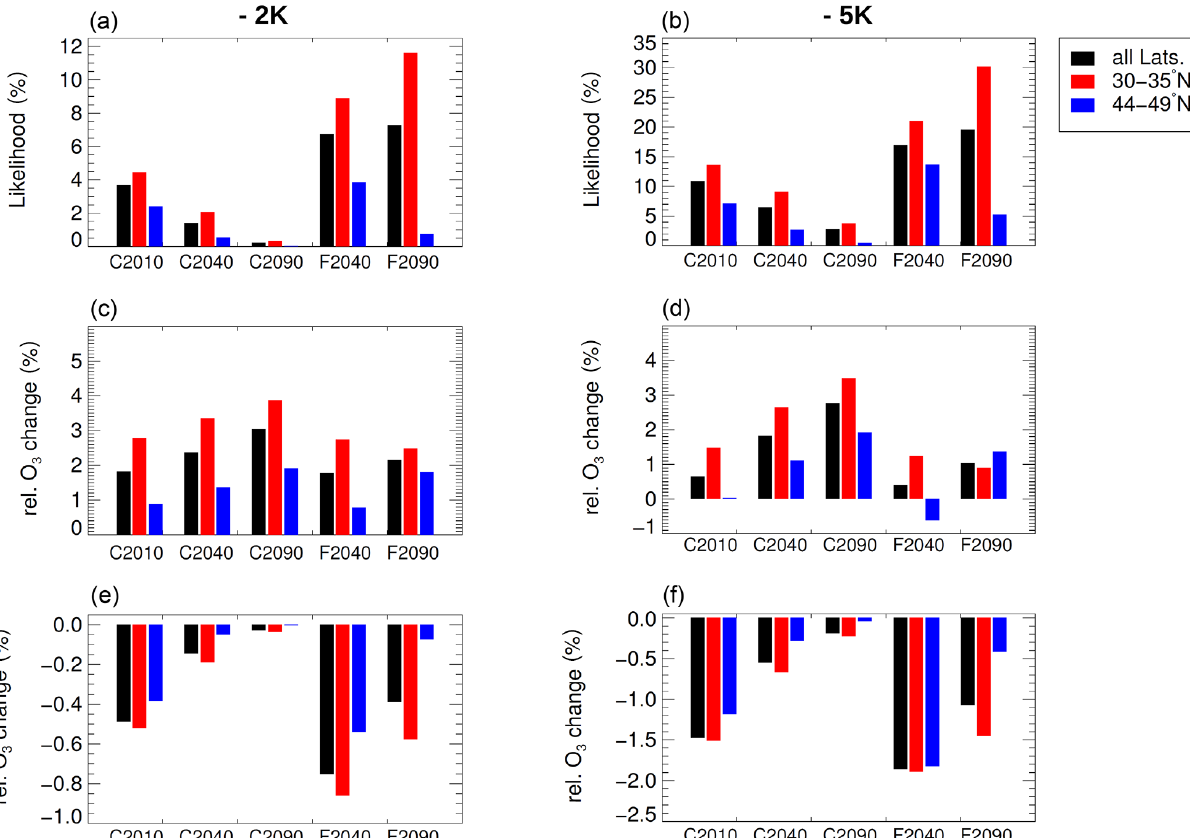
Figure 11. Likelihood (a, b) for the occurrence of chlorine activation as well as its impact on ozone in the lowermost stratosphere assuming 2K (a, c, e) and 5K (b, d, f) lower temperatures than simulated in GLENS. Further, the chemical ozone change in the mixing layer assuming 10 consecutive days without mixing of air parcels (c, d) and the relative ozone change in the mixing layer caused by heterogeneous chlorine activation (e, f) is shown for the assumption with 2 and 5K less temperatures. Note that the scale on the y axes differs (see Table 1 for case